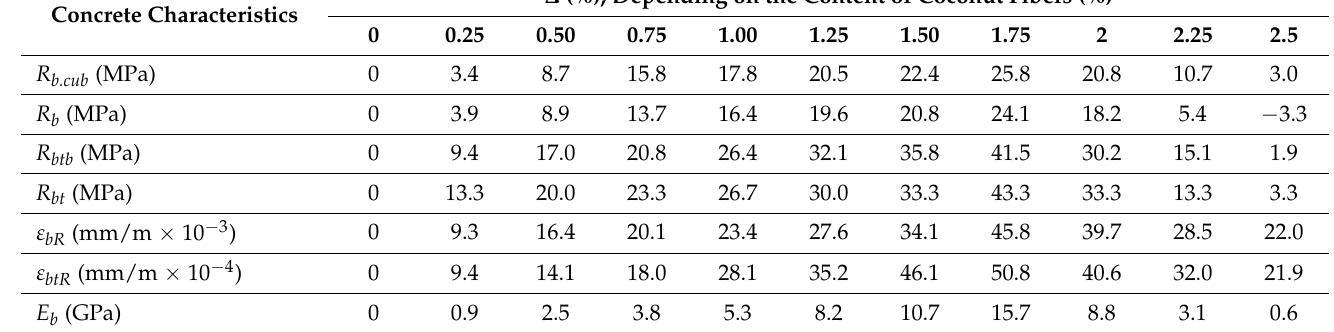
Table 5. Influence of the percentage of FDRC with coconut fibers on the strength and deformation characteristics of concrete samples ( ∆